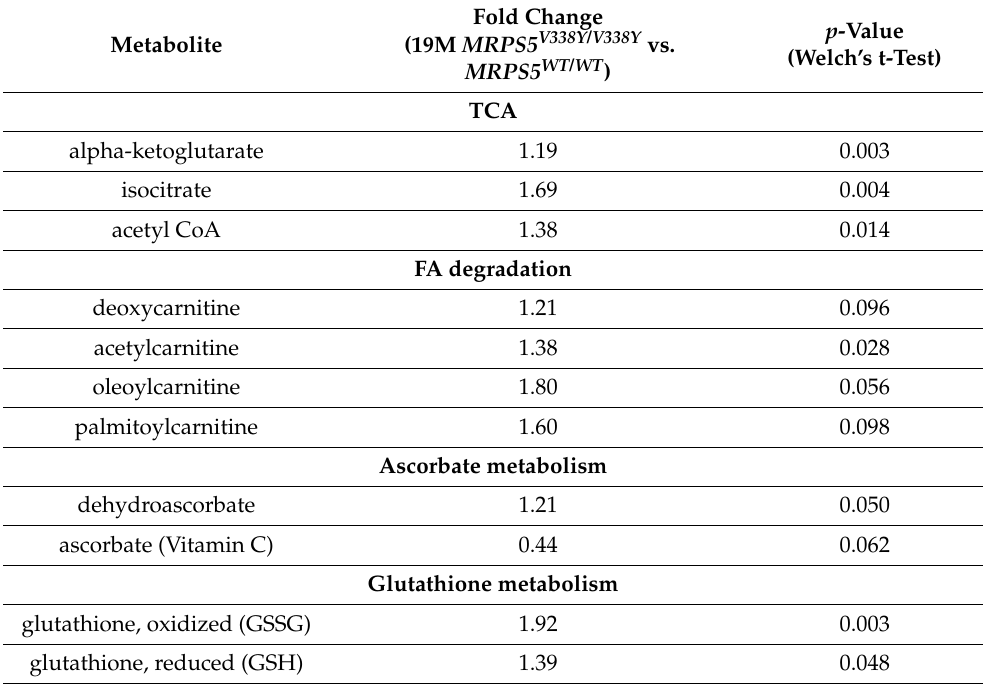
Table 2. Selected metabolites with different pool sizes in 19-month-old MRPS5 V338Y/V338Y mutant compared to wild-type